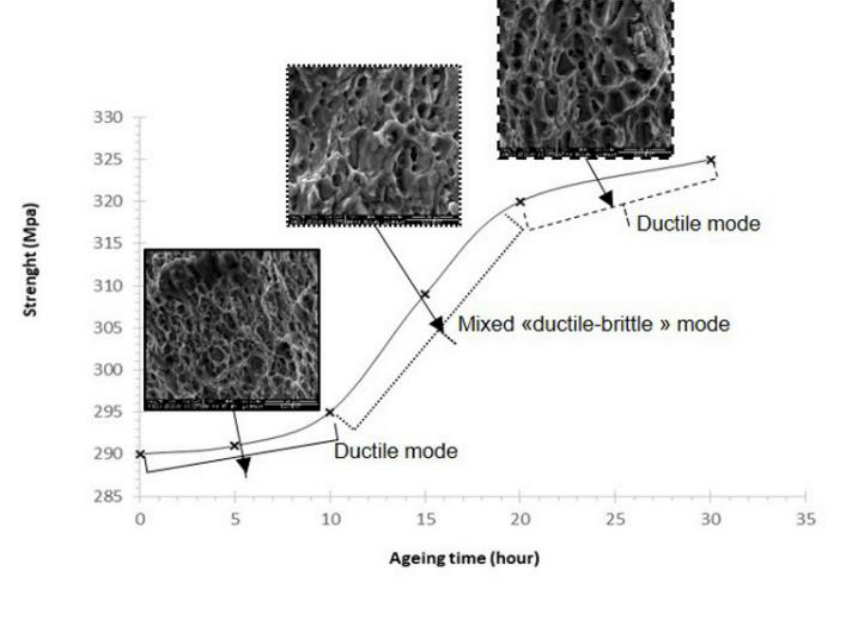
Fig. 10. Summary of the mode of fracture for the tensile samples tested under different aging